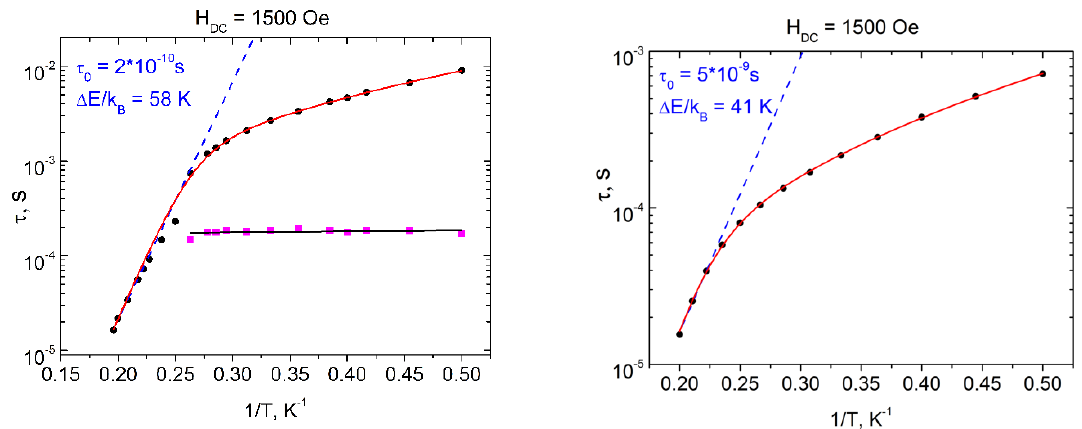
Figure 13. Relaxation time versus 1/T for 1 ( left ) and 2 ( right ) under an applied magnetic field of H DC = 1500 Oe. Black circles and pink squares indicate low- and high-frequency peaks on χ″(ν). The data were obtained by approximating the frequency dependences of the dynamic magnetic susceptibility using the two-component (1) and one-component (2) generalized Debye models. The blue line is the approximation of high-temperature data by the Arrhenius equation. The red line is the approximation of the entire data range by the combination of the Orbach and Raman relaxation mechanisms. The approximation of the second process by the QTM is shown by the black line.